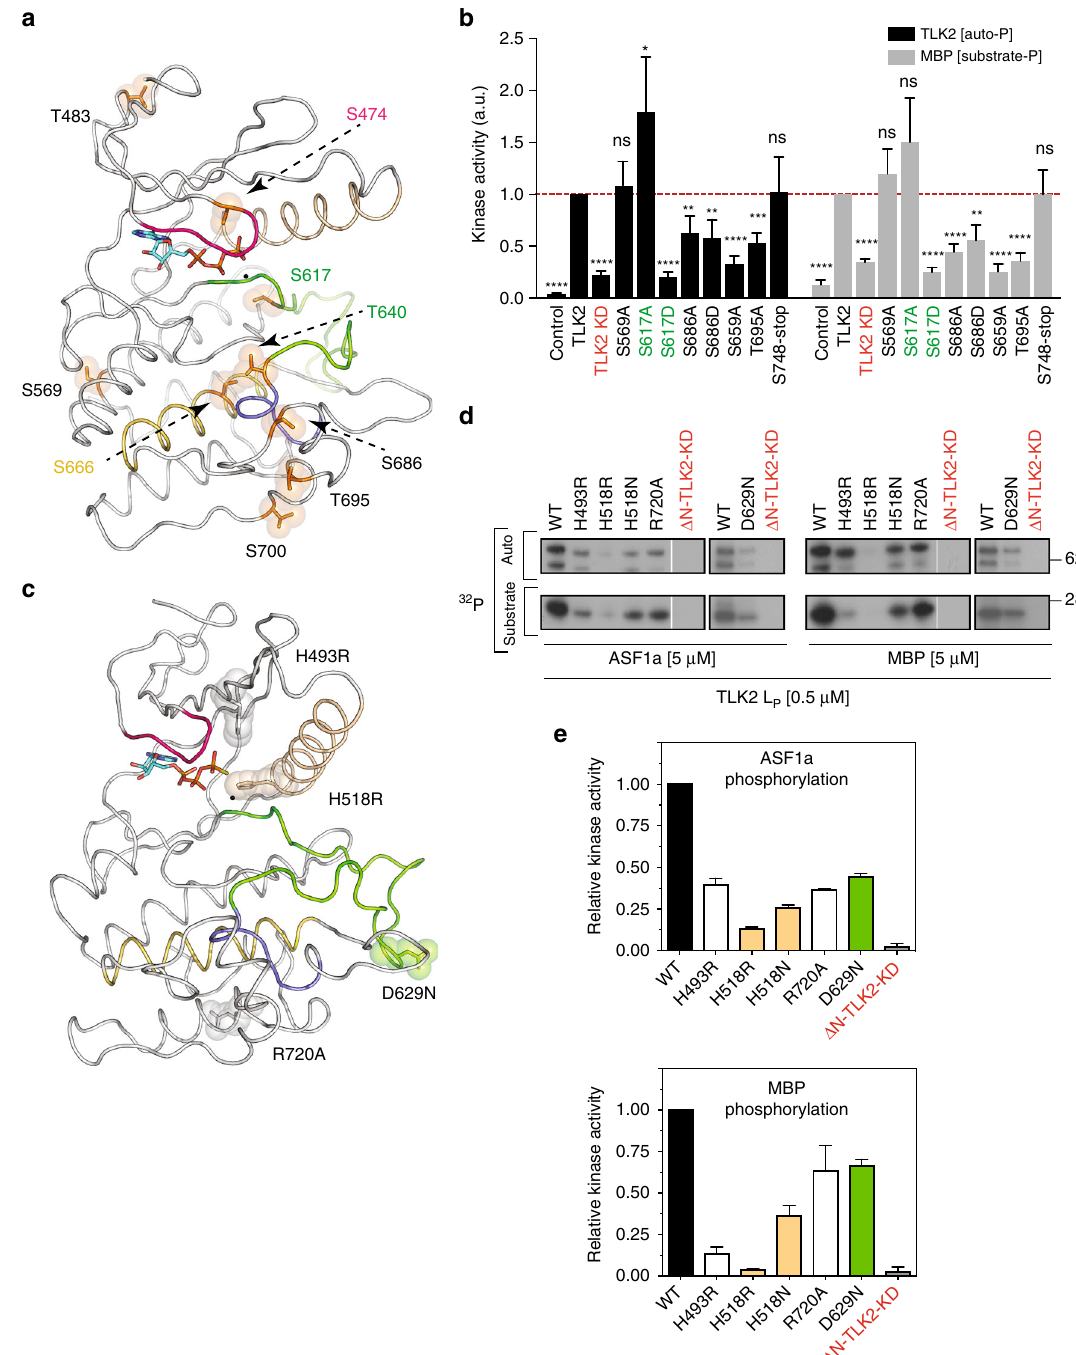
Fig. 5 Phosphorylation sites in the kinase domain. a Nine out of the 15 phosphorylation sites in the kinase domain can be modelled on the structure. The sites are highlighted in stick and sphere representation and lie in the N-lobe, activation loop and C-lobe. The six phosphosites on the C-tail cannot be observed because the crystallized construct lack that segment. b In vitro kinase assay of the indicated phosphorylation mutants of TLK2 isolated from AD293 cells by Streptavidin pull-downs showing relative autophosphorylation and MBP phosphorylation (see Supplementary Figure 9a for the autoradiograms and Supplementary Figure 9b IP pull-downs). The KD in this experiment bears the D592V mutation instead of the D613A. c Structure of the kinase domain highlighting the position of the intellectual disorder and cancer mutants. The amino acids where mutations have been reported are shown in stick – sphere representation. d In vitro kinase assay of the different ID and cancer mutants using MBP and ASF1a as substrates. e Quanti fi cation and comparison with the wild-type protein is represented in a histogram. The data points indicate the relative kinase activity of the TLK2-mutants normalized to the activity of the wild-type protein (mean ± s.d., n = 3 biological replicates). See Supplementary Figure 9c – f for MBP and ASF1a phosphorylation and autophosphorylation activities by the